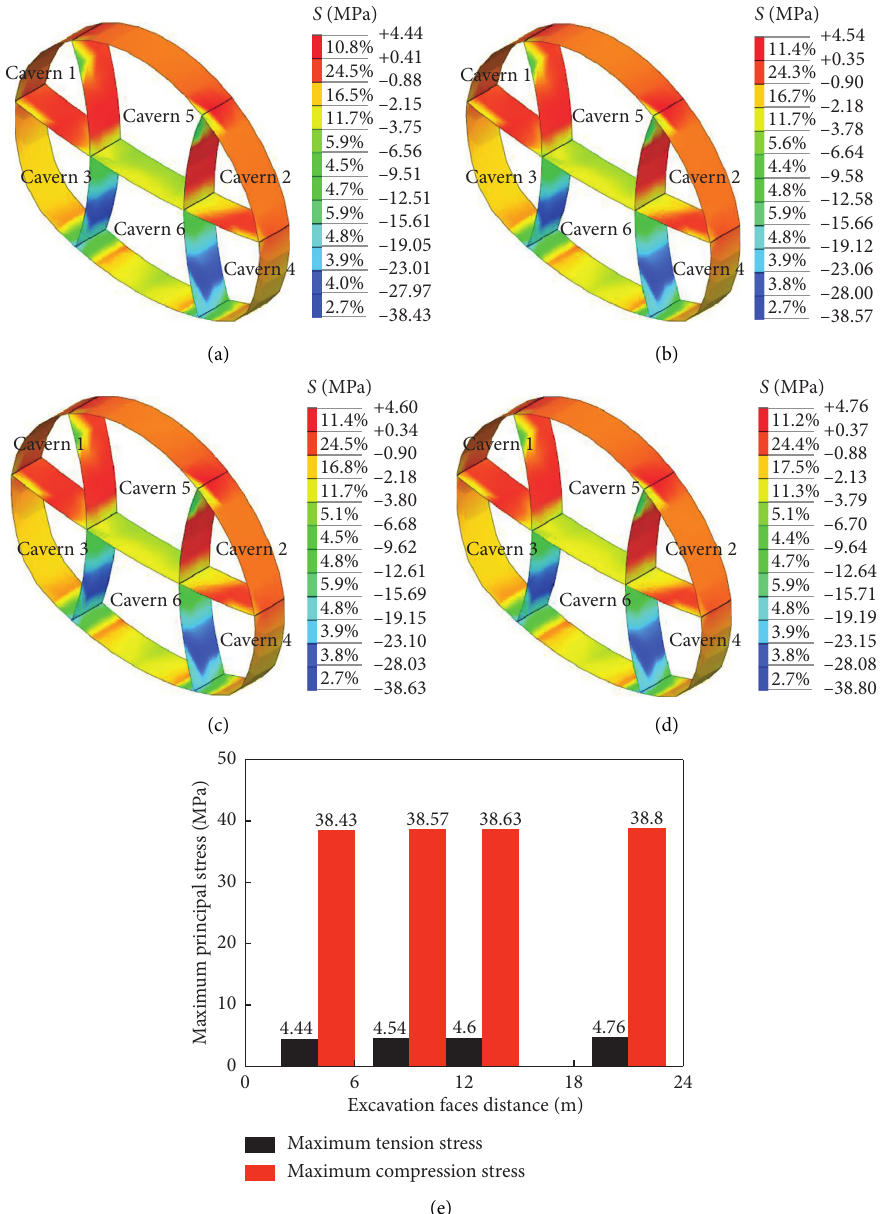
Figure 14: Principal stress characteristics of supporting structure of the CK9 +462 section. (a) L L 3 � 21m. (e) Relationship between maximum principal stress and excavation face distance ( L 3